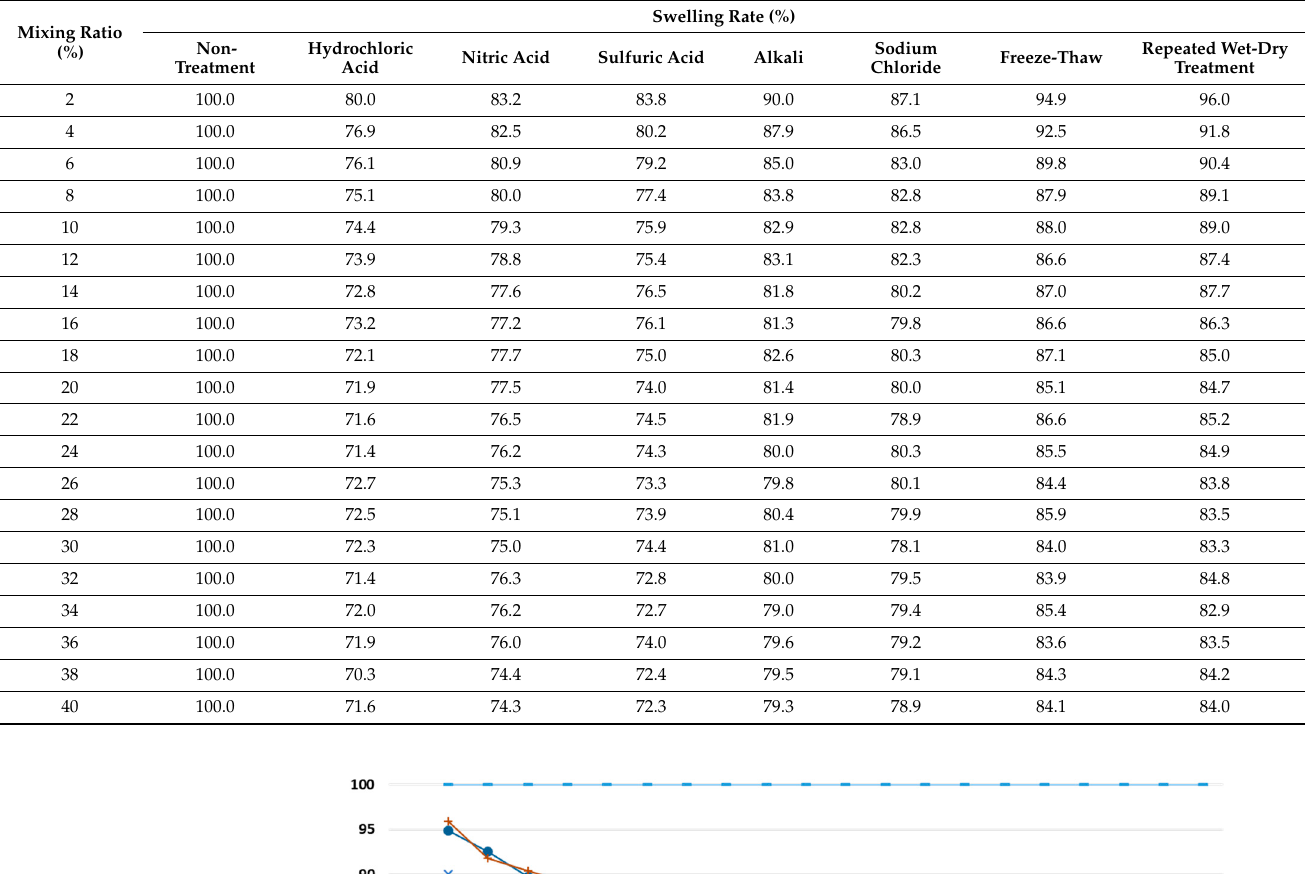
Table 8. The analysis of the degree of decrease in the swelling rate according to the deterioration conditions for each superabsorbent polymer content.